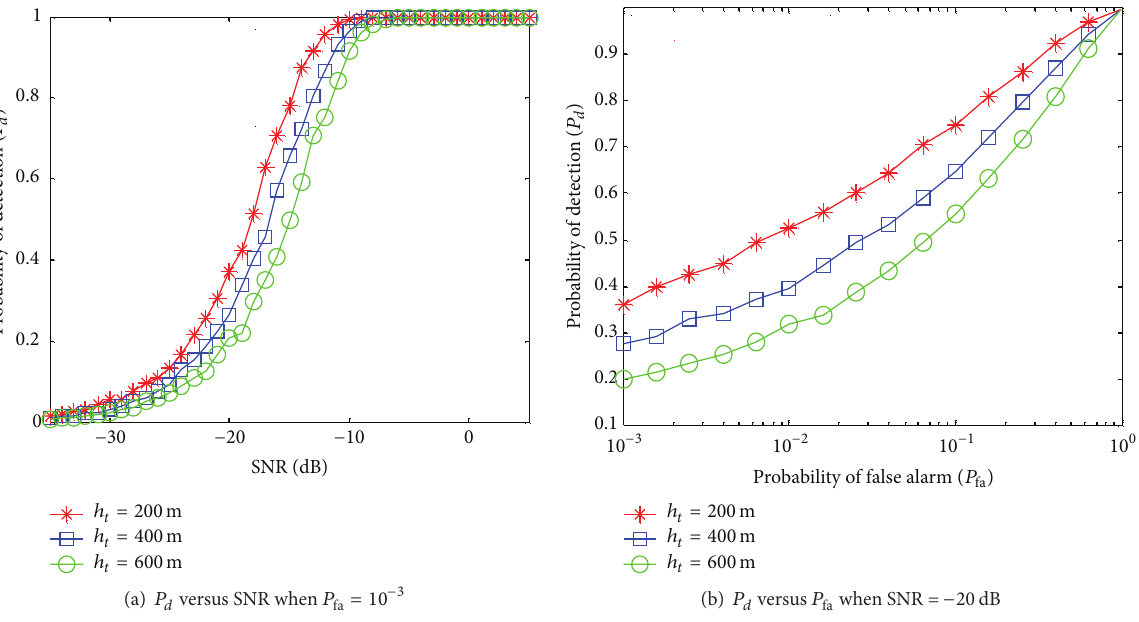
Figure 6: Detection performance varies with target height.